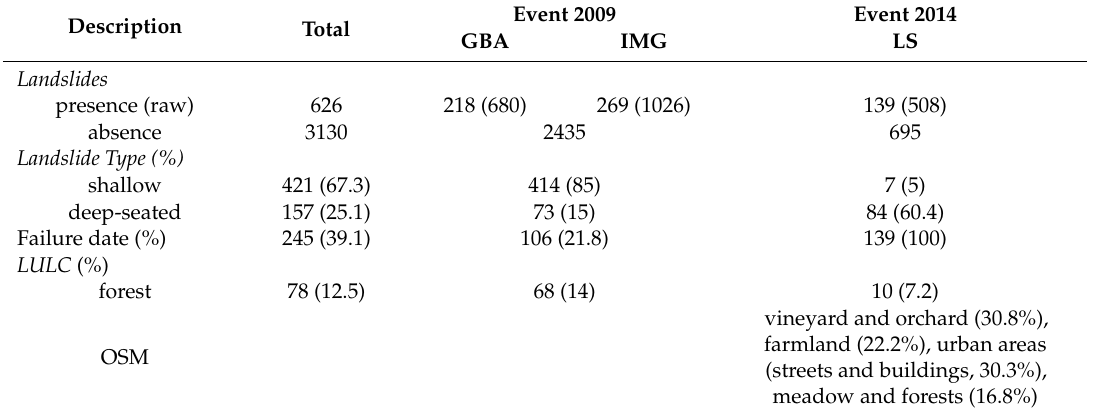
Table A2. Landslide data.